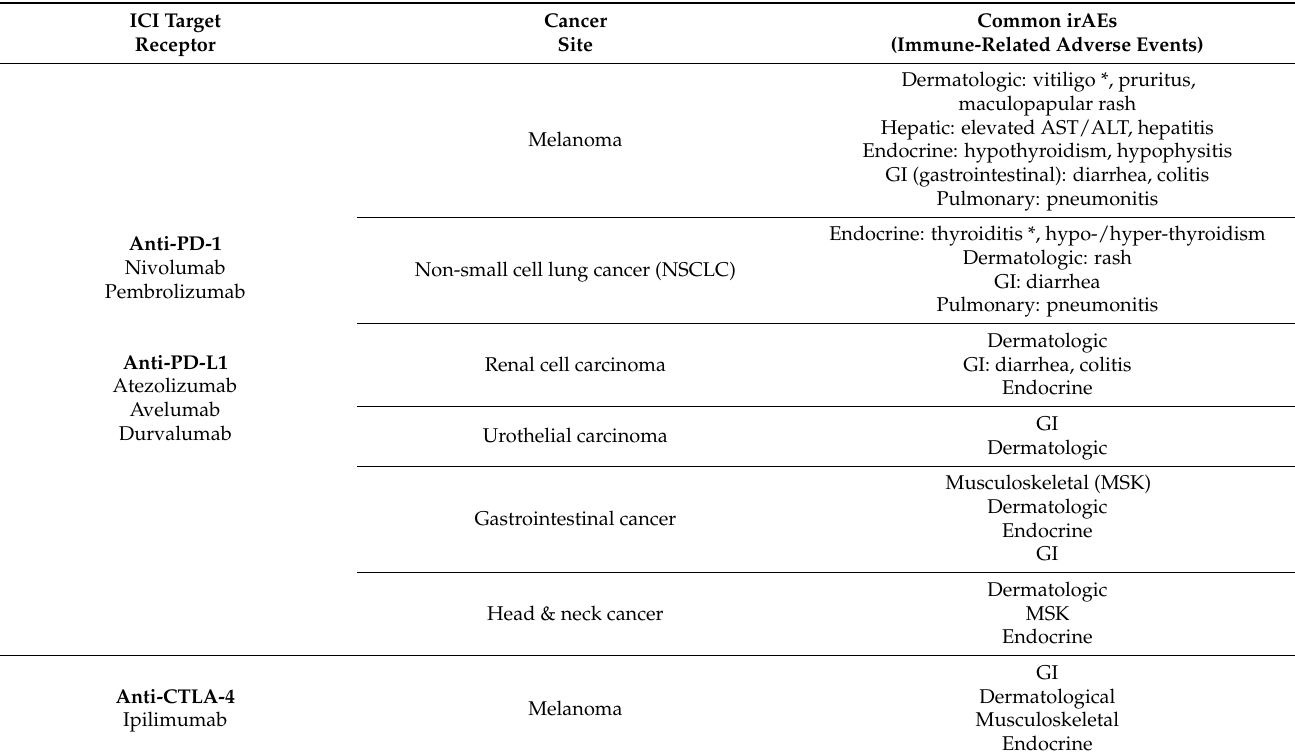
Table 1. Overview of frequent irAEs by ICI therapeutic target and cancer site.